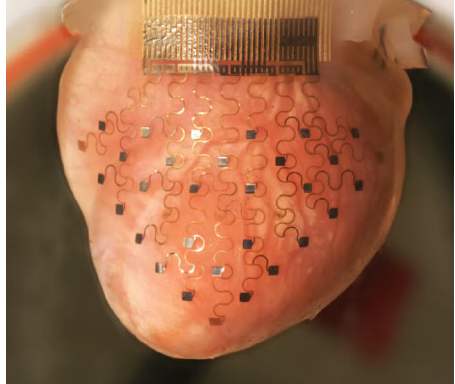
Figure 31. Cardiac membrane fitted to a rabbit’s heart [186].